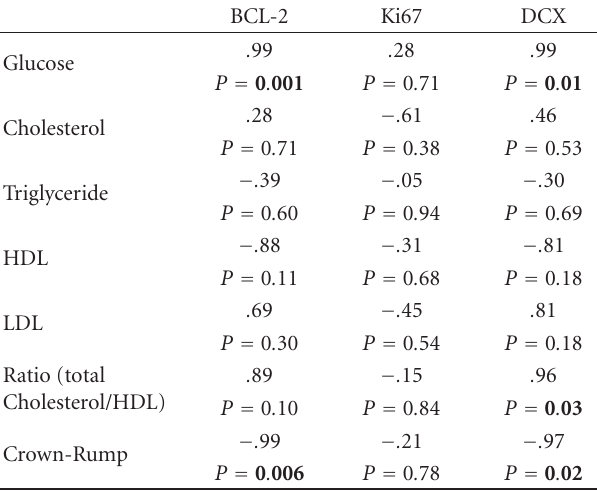
Table 2: Pearson’s correlations between neurogenesis-related pa- rameters in the dentate gyrus of the hippocampus and in vivo met- abolic parameters (significant at P < 0 .